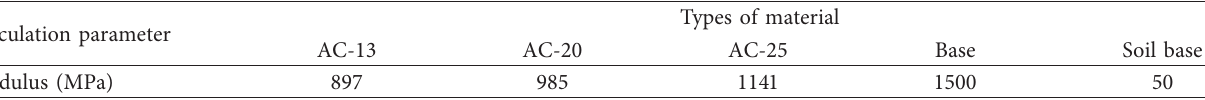
— — Table 2: Calculation parameter of the materials.